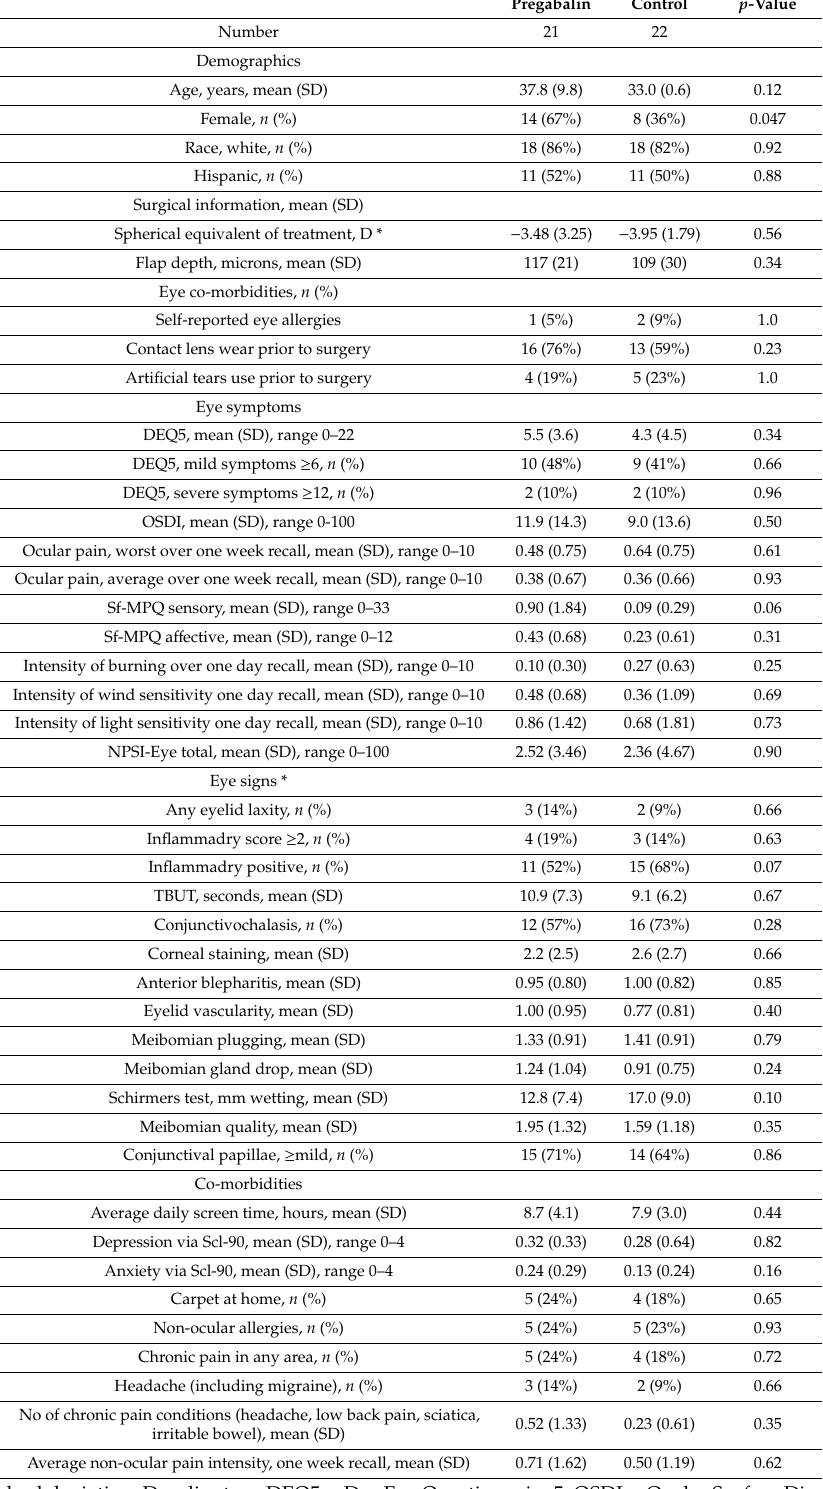
Table 1. Comparison of demographics, co-morbidities, DE metrics, and treatment parameters between the two groups at